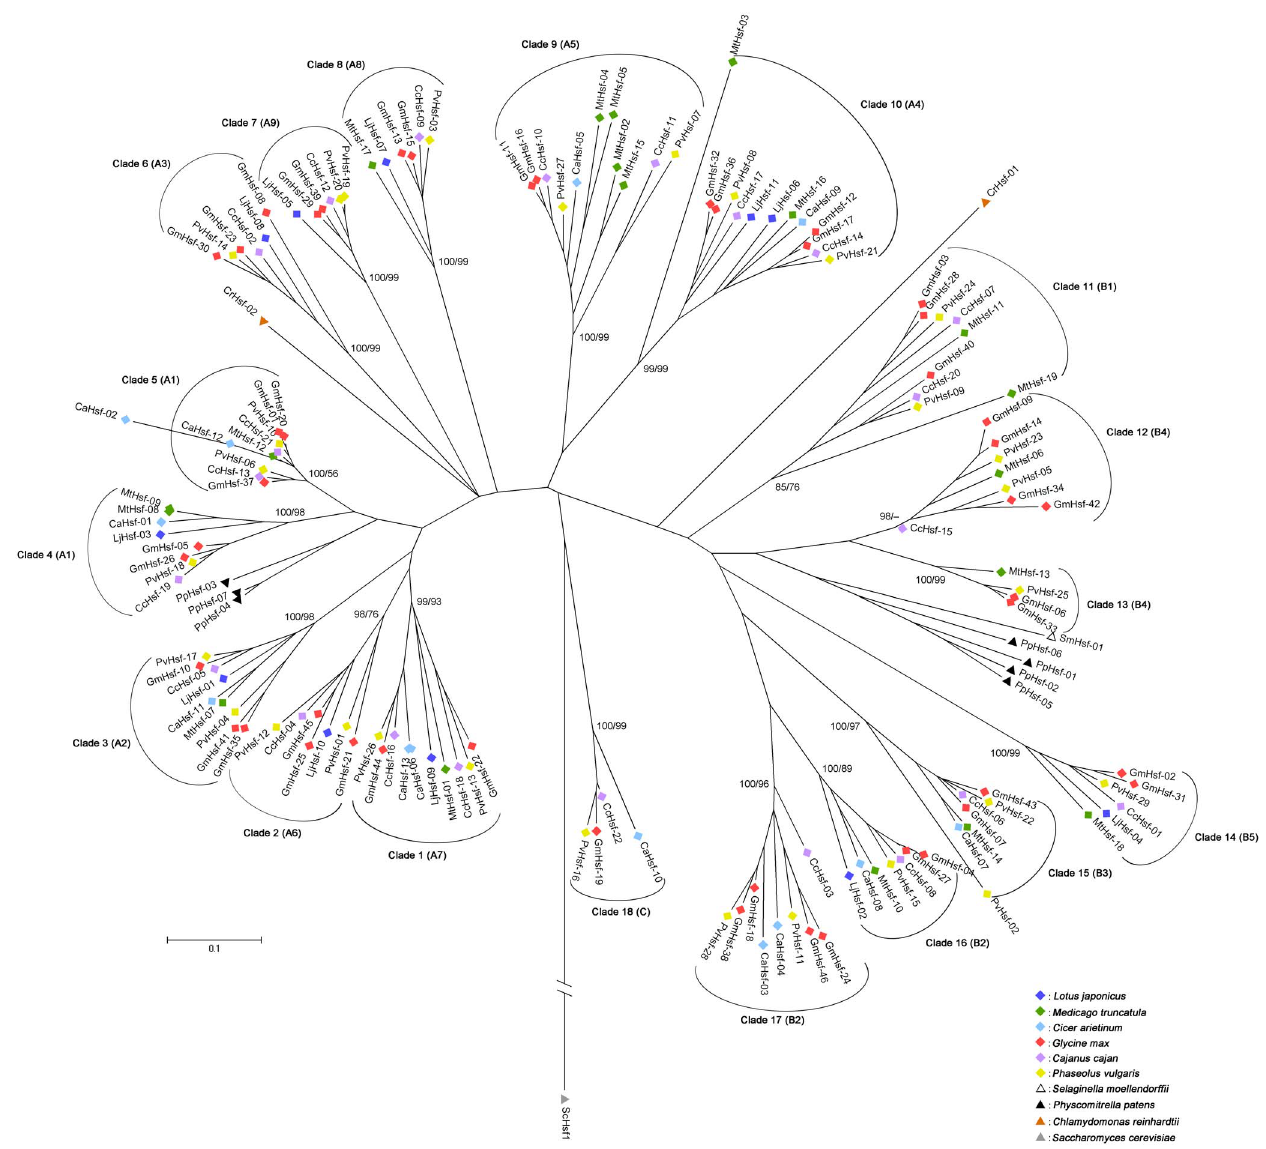
Figure 1. Phylogenetic tree of 140 Hsf proteins from L.japonicus , M.truncatula , C.arietinum , G.max , C.cajan and P.vulgaris . This tree was constructed based on amino acid sequence comparison of the conserved N-terminal regions of Hsfs including the DNA-binding domain, the HR-A/B region and parts of the linker between them, using the neighbor-joining method with 1,000 bootstrap replicates. The Hsf of Saccharomyces cerevisiae (ScHsf1) and the Hsfs of C. reinhardtii , S. moellendorffii and P. patens were used as the outgroup. The colors indicate the species background of the Hsfs. The tree was divided into 18 shared clades (Clades 1–18) according to evolutionary distances. The bootstrap values of both neighbor-joining (NJ) tree (first number; 1000 replicates) and maximum likelihood (ML) tree (second number; 1000 replicates) were shown on the branches leading to each of the clades. The clades were supported by high bootstrap values in neighbor-joining and maximum likelihood analyses. Different subclasses of Hsfs are indicated in brackets. Gene names are presented in Table S2. The scale bar represents 0.1 amino acid changes per